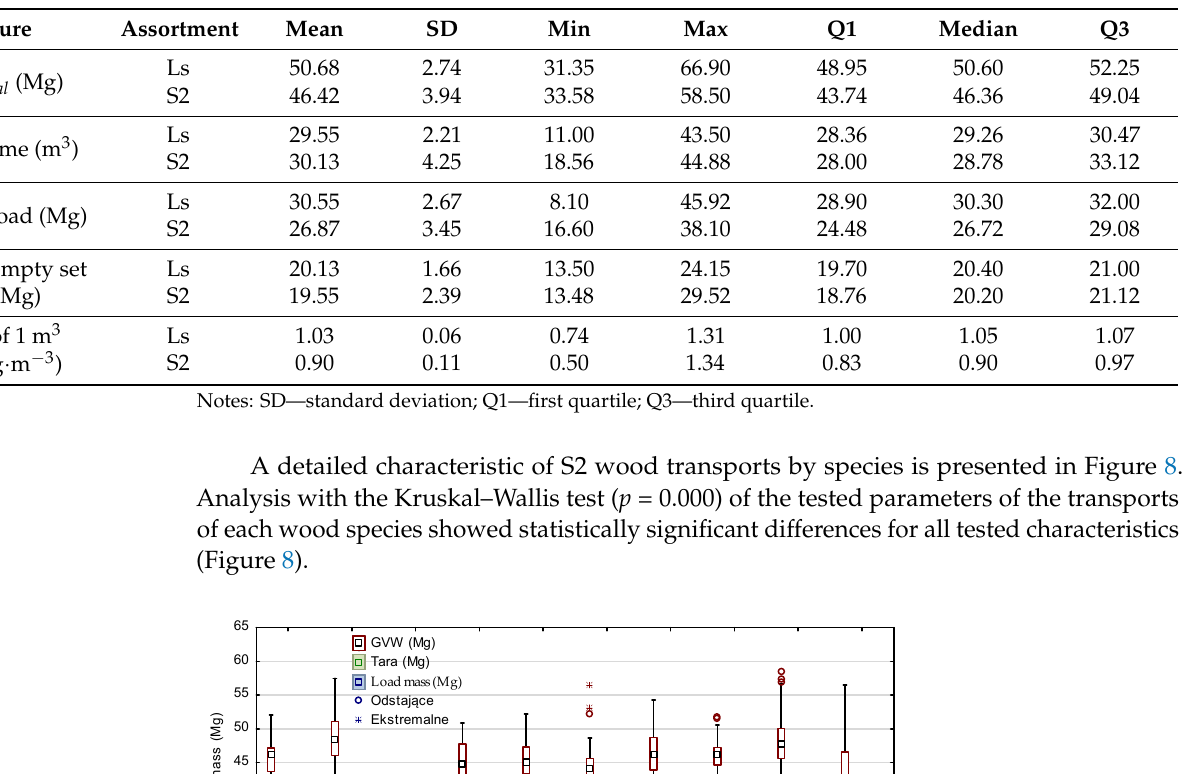
Table 3. Characteristic of wood deliveries parameters.